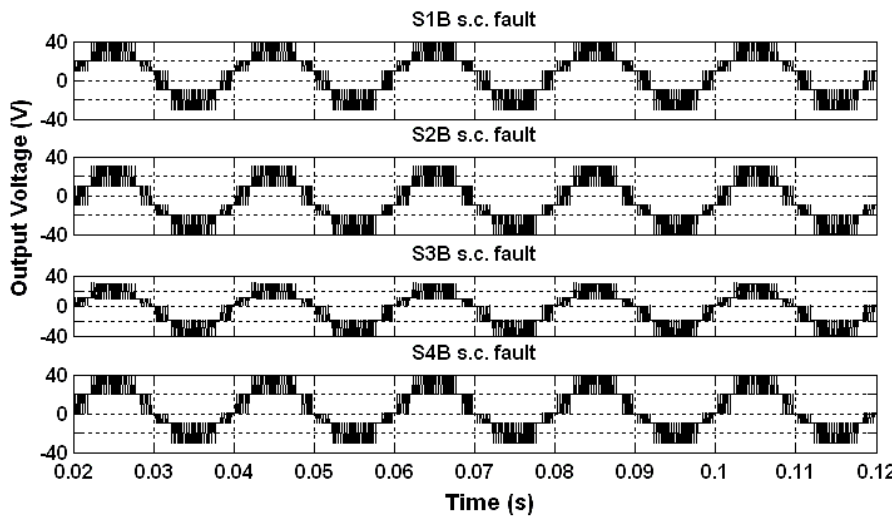
Figure 16. Short Circuit fault condition output voltage waveforms.